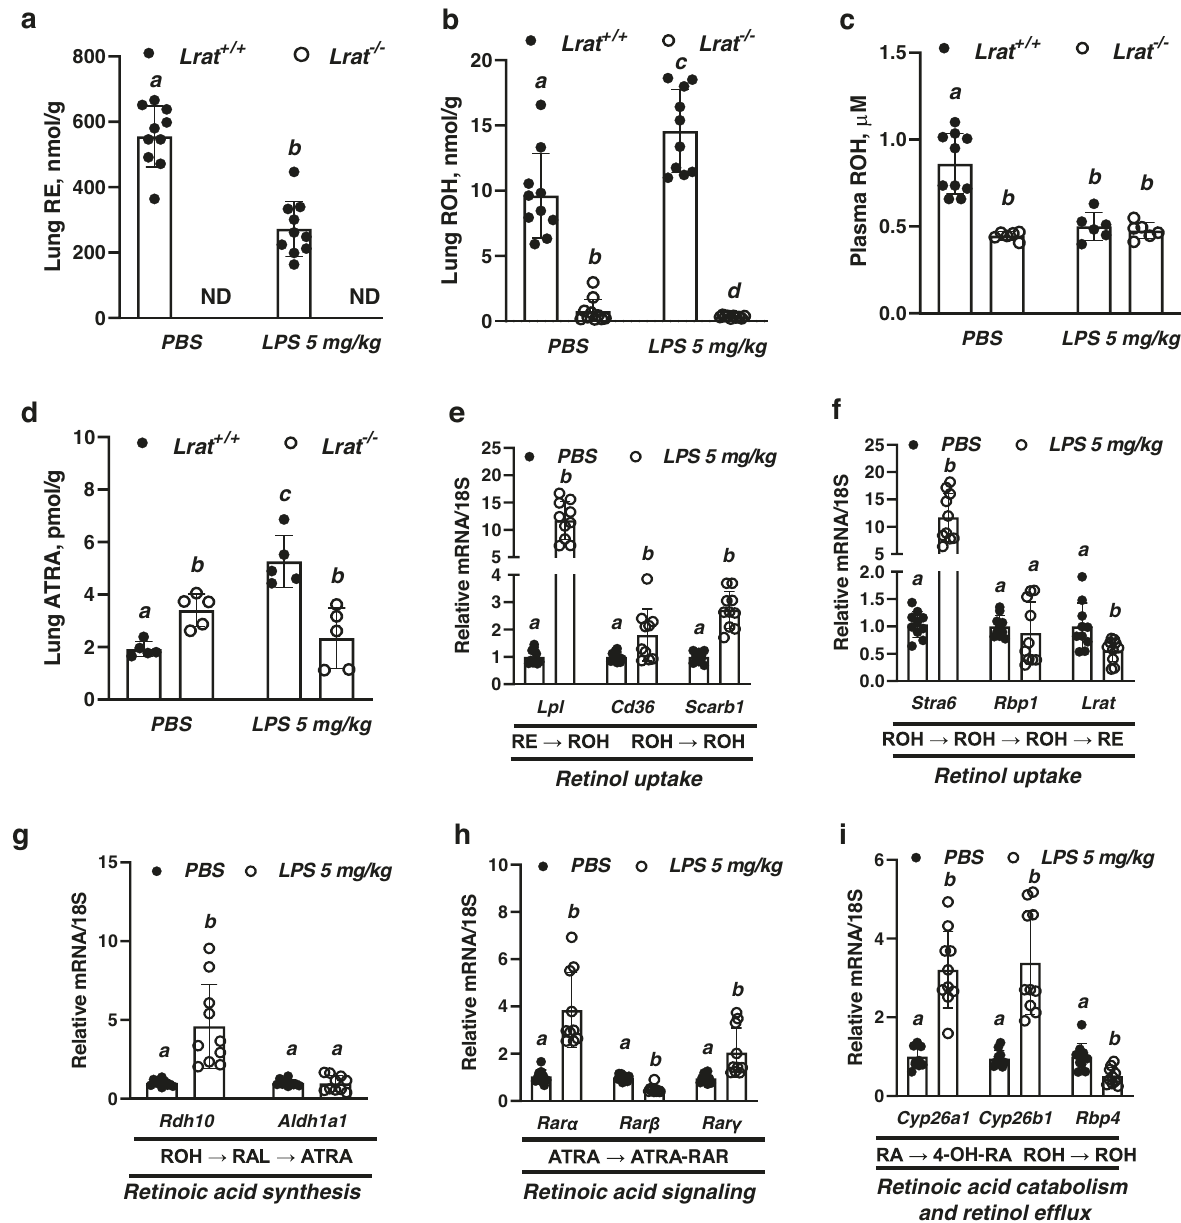
Fig. 6 | Retinoid concentrations and retinoid-related transcript levels ofgenes mediating retinoid metabolism in mouse lungs during early periods of ALI. a Lung totalretinylester (RE,nmol/g) concentrations determined by HPLCinmice 24hafterintranasalinstillationofLPS(5mg/kgofbodyweightinPBS)orPBSalone. Values marked with different letters (a, b) are statistically different (a is different from b, p =1.28e-06). Statistical differences were analyzed by a one-way ANOVA. All values are given as the mean±1S.D., n =10 for each group. b Lung retinol (ROH, nmol/g) concentrations determined by HPLC in mice 24h after intranasal instillation of LPS (5mg/kg of body weight in PBS) or PBS alone. Values marked with different letters (a, b, c, d) are statistically different (a is different from b, p =3.63e-10; c is different from d, p =7.50e-16; a is different from c, p =3.11e-05). Statisticaldifferenceswere fi rstanalyzedbyaone-wayANOVAfollowedbymultiple comparisons employing Tukey ’ s HSD post hoc test. All values are given as the mean±1S.D., n =10 for each group. c Plasma retinol (ROH, µ M) concentrations determined by HPLC in mice 24h after intranasal instillation of LPS (5mg/kg of body weight in PBS) or PBS alone. Values marked with different letters (a, b) are statistically different (a is different from b, p =2.95e-06). Statistical differences were fi rst analyzed by a one-way ANOVA followed by multiple comparisons employing Tukey ’ s HSD post hoc test. All values are given as the mean±1S.D.,